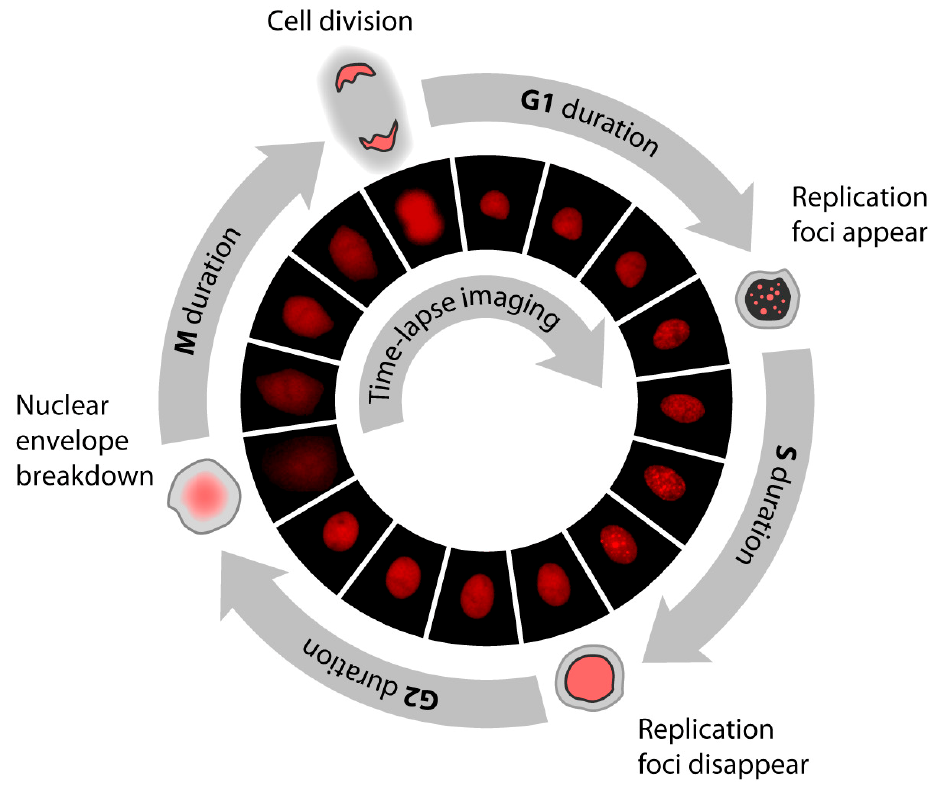
Figure 4. Time lapse analysis of the cell cycle using fluorescently labeled PCNA. Scheme of the cell cycle composed of G1, S, G2, and M phases (not to scale). Duration of particular cell cycle phases were quantified using time lapse fluorescence microscopy by a PCNA-mCherry reporter to identify four discrete events during the lifetime of an individual cell. Fluorescence images were acquired using a Nikon Ti Eclipse inverted microscope with a Nikon Plan Apochromat Lambda 40× objective with a numerical aperture of 0.95 using an Andor Zyla 4.2 sCMOS detector. In addition, the Nikon Perfect Focus System (PFS) was employed in order to maintain focus of live cells throughout the entire acquisition period. The microscope was surrounded by a custom enclosure (Okolabs) in order to maintain a constant temperature (37 °C) and atmosphere (5% CO 2 ). NIS-Elements AR software was used for image acquisition and analysis. Images were acquired every 10 min. Adapted from [59].